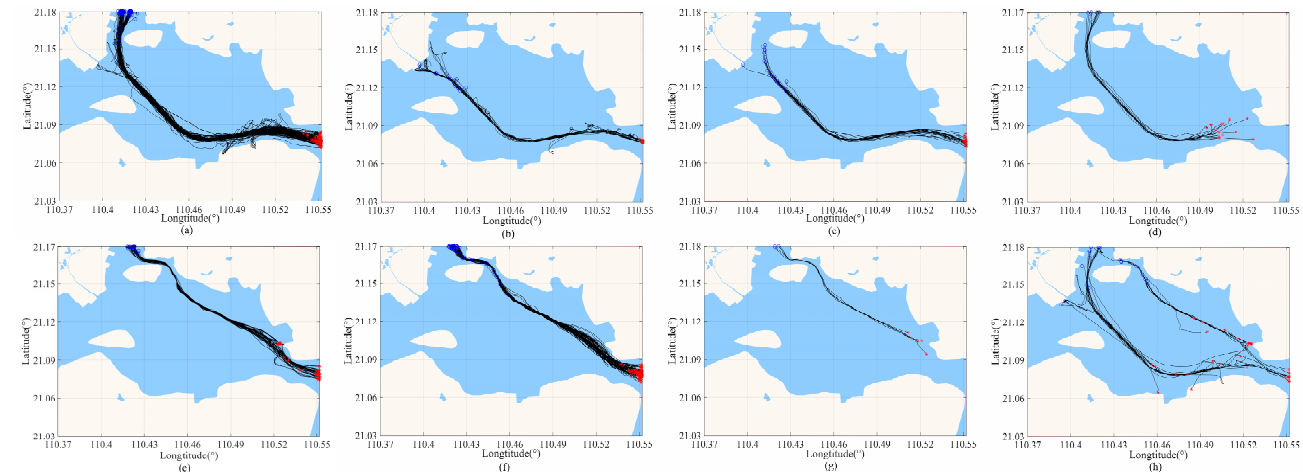
Figure 16. DBSCAN clustering results of Figure 9c with MinLns = 5 and ε = 0.085. ( a ) Class A; ( b ) Class B, 18; ( c ) Class C, 22; ( d ) Class D,13; ( e ) Class E, 36; ( f ) Class F, 98; ( g ) Class G, 5; ( h ) abnormal trajectories, 30.